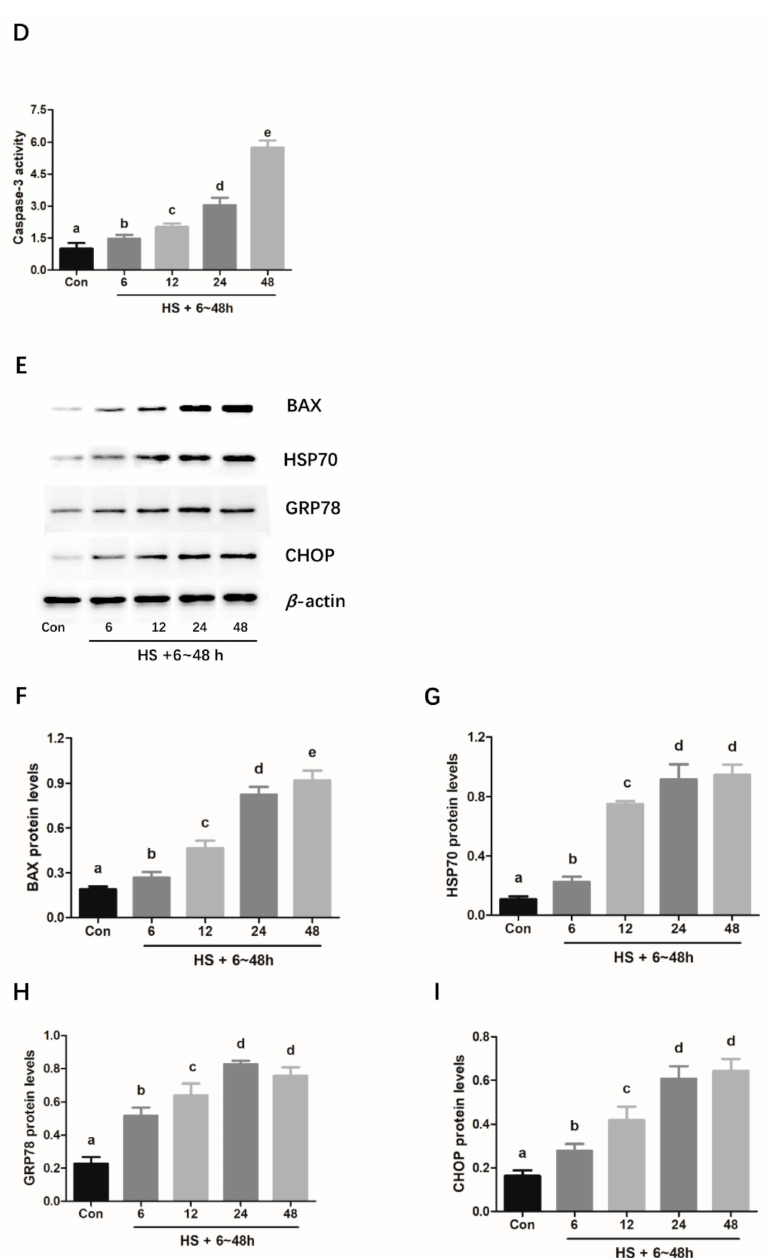
Figure 1. Chronic heat stress induces apoptosis and ER stress in mouse granulosa cells. Cells were cultured at 39 ◦ C for heat stress for di ff erent periods of time (0, 6, 12, 24, and 48 h). Then, the treated cells were harvested for performing the CCK-8 assay ( A ) and flow cytometry-based analysis of apoptosis ( B and C ). Caspase-3 activity was measured by using a Caspase 3 Activity Assay Kit ( D ). Western blotting ( E ) was used to analyze the protein expression levels of cell apoptosis-related BAX ( F ), heat stress-related marker protein HSP70 ( G ) and ER stress activation markers, GRP78 ( H ) and CCAAT / enhancer binding protein homologous protein (CHOP) ( I ). β -actin was used for normalizing the level of protein expression. The results of data analysis are shown as the bar graphs. The data are presented as mean ± SEM of three independent experiments, and each independent experiment includes three technical replicates. Bars with di ff erent lowercase letters are significantly di ff erent ( p <